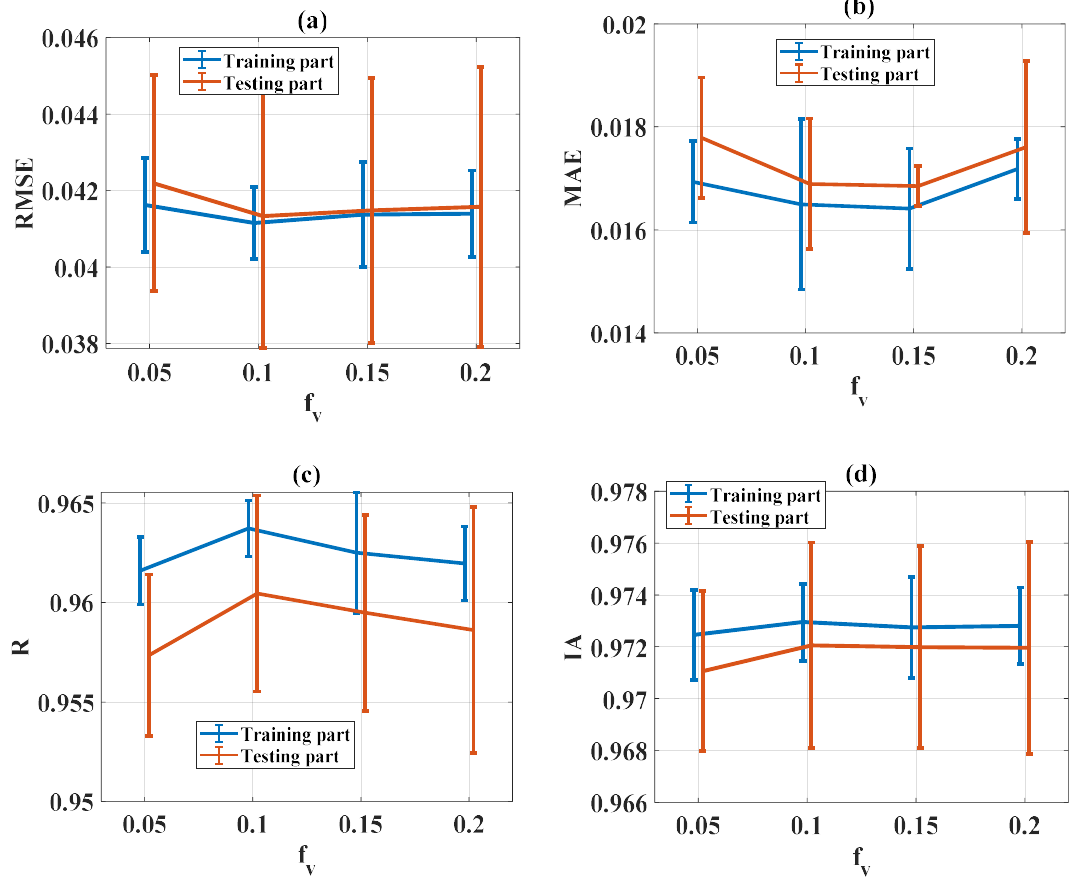
Figure 13. Evaluation of statistical criteria in the function of f v : ( a ) RMSE, ( b ) MAE, ( c ) R and ( d ) IA.